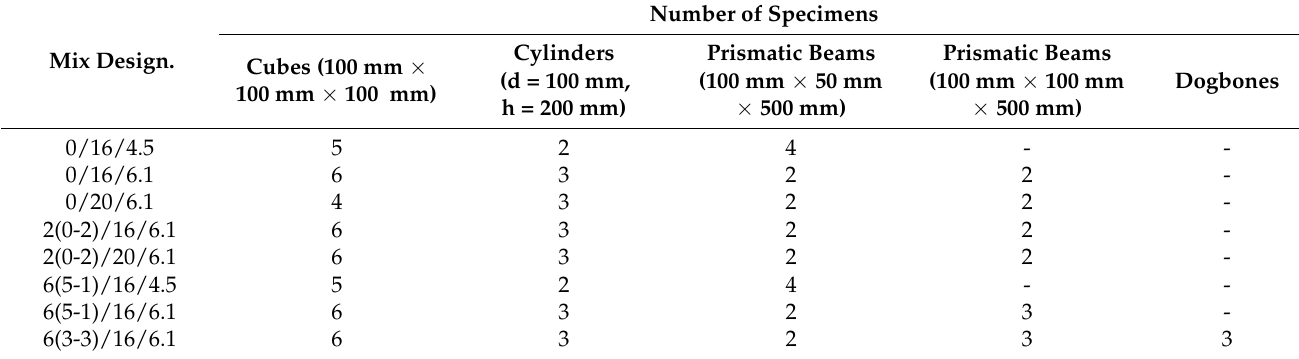
Table 3. Number and dimensions of